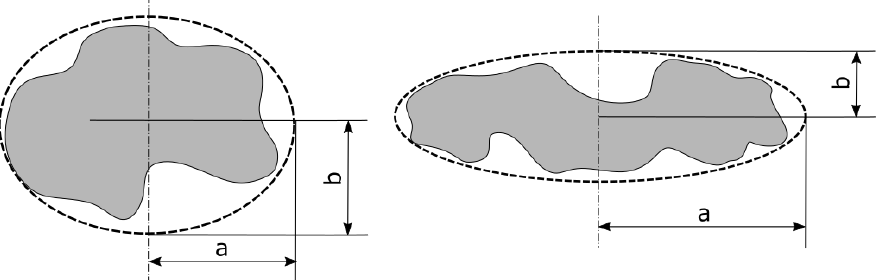
Figure 1. Sketch of a section of an hypothetical real particles in grey and the equivalent elliptical geometries in dashed line. Aspect ratio is defined as α = a / b . Ellipsoid is constructed rotating one half of the section around its central vertical